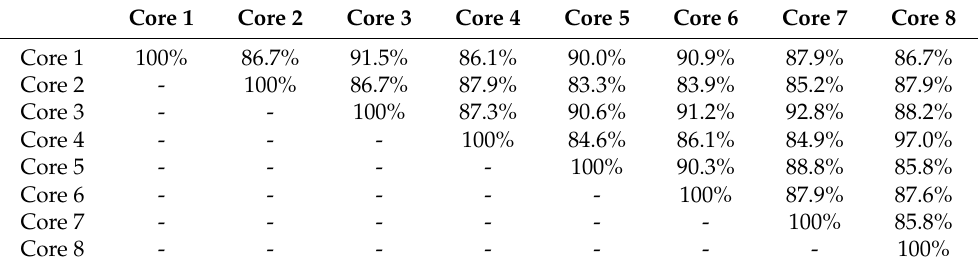
Figure 1. The human astrovirus capsid. ( A ) Schematic of the human astrovirus capsid protein and the recombinant spike antigen used in this study. ( B ) The mature human astrovirus particle, with the spike in cyan and the core in dark blue (adapted from [28]). Table 1. Sequence identity matrix across capsid core domains from human astrovirus serotypes 1–8.